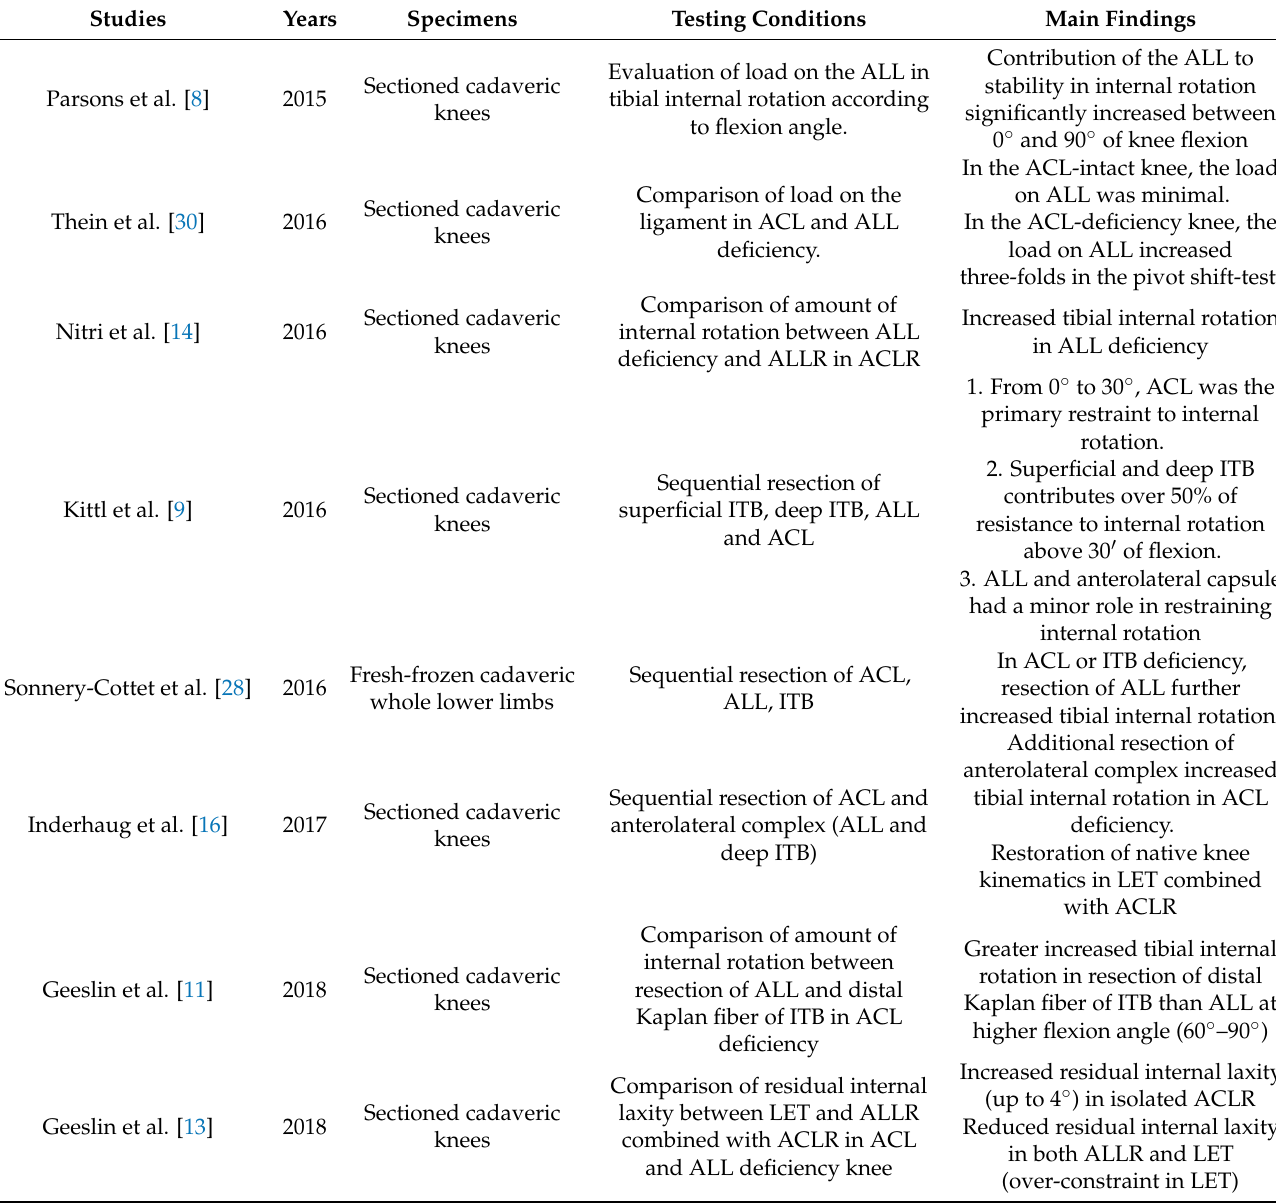
Table 1. Summary of biomechanical studies on anterolateral complex and anterolateral ligament of the knee